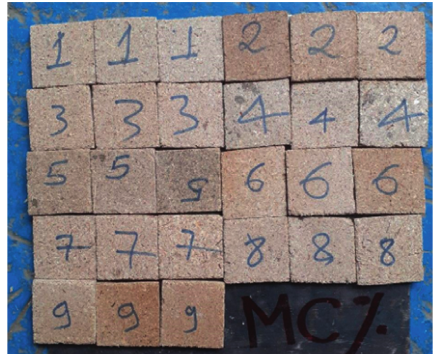
Figure 4: Boards for moisture content